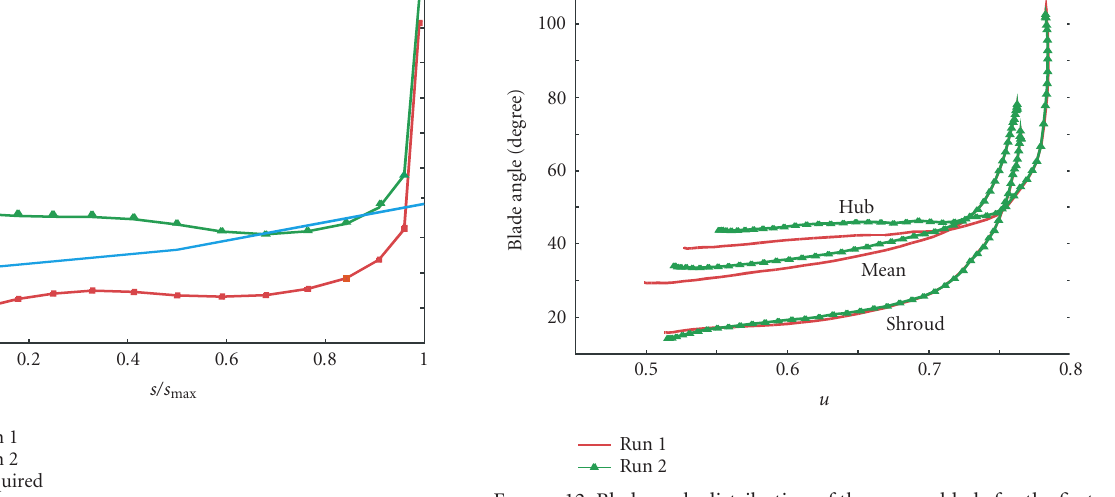
Figure 12: Blade angle distribution of the runner blade for the first and the second optimization